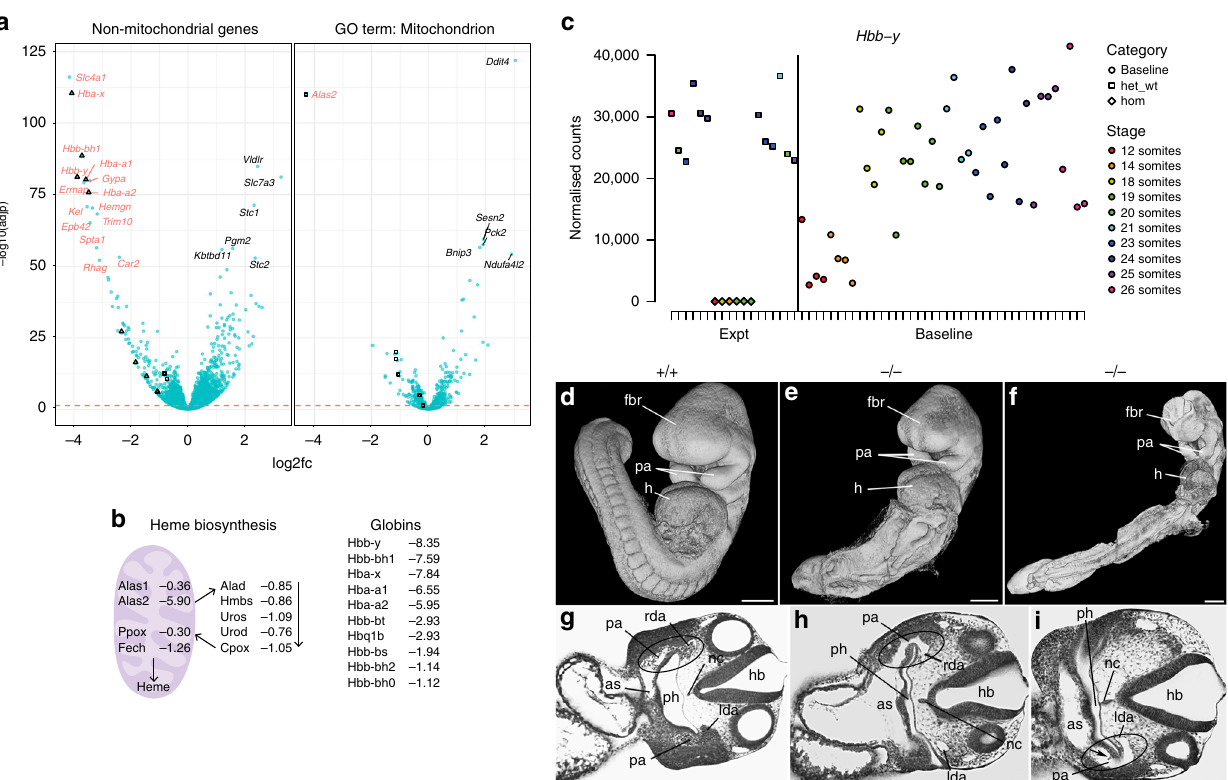
Fig. 6 Phenotype of the Nadk2 line. a Volcano plots of genes in the Nadk2 mutant line. log 2 [fold change] is plotted on the x -axis and − log 10 [ p value] on the y -axis. Genes associated with Gene Ontology term GO:0005739 (mitochondrion) are shown on the right and those not associated are on the left. Squares indicate genes from the heme biosynthesis pathway and triangles are haemoglobin genes. Gene names in red are associated with erythrocyte development. b Genes involved in the heme pathway on the left and haemoglobins on the right, plus their log 2 [fold change] in the Mutant Response. Genes whose products are localised to mitochondria are shown inside the purple oval. c Example count plot for Hbb-y , containing samples from the mutant line as well as somite stage-matched baseline samples. Homozygous embryos are shown as diamonds, siblings (heterozygous and wild-types) are squares and baseline samples are represented by circles. Points are coloured according to stage. d – i High-resolution episcopic microscopy data for the Nadk2 line. d – f 3D models of the embryo surface. d Wild-type embryo ( + / + ). e , f Homozygous mutant embryos ( − / − ); e is mainly delayed in its caudal body parts, whereas f is globally delayed. fbr forebrain, h heart, pa pharyngeal arch. g – i Corresponding axial sections from the embryos in ( d – f ) at the level of the heart. as aortic sac, pa pharyngeal arch artery, lda left dorsal aorta, rda right dorsal aorta, ph pharynx, hb hindbrain (respectively fourth ventricle), nc notochord. The control embryo ( g ) has a large number of clearly visible blood cells in the aortic sac and arteries, whereas the homozygotes have no, h (4 of 6), or very few, i (2 of 6), erythrocytes (arrow). Compare circled areas in ( g , h and i ). Scale bars are 250 µ m. Source data are provided as a Source Data fi